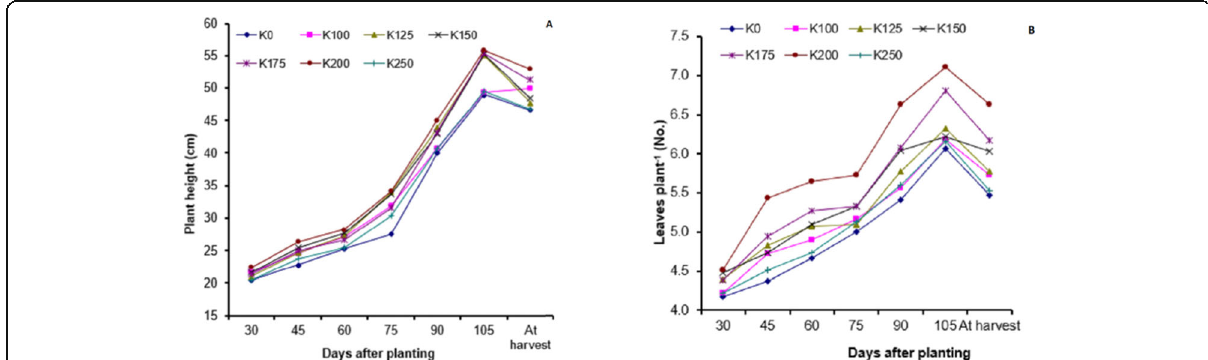
Fig. 1 effects of potassium on a plant height and b plant leaves of garlic at different days after planting. K0: 0 kg K (only soil), K100: 100 kg K, K125: 125 kg K, K150: 150 kg K, K175: 175 kg K, K200: 200 kg K, K250: 250 kg K